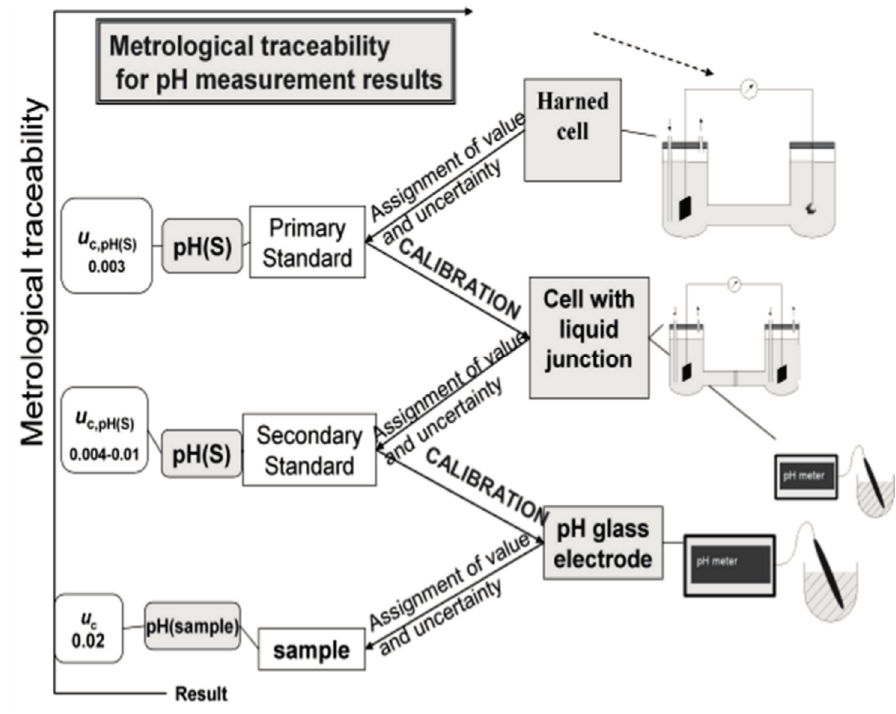
Figure 1. Metrological traceability scheme for pH. U c denotes the expanded measurement uncertainty (coverage factor k = 2; the value of the measurand lies with a probability of approximately 95% within the interval of values) assigned to the pH values obtained for aqueous solutions up to an ionic strength of 0.1 mol·kg − 1